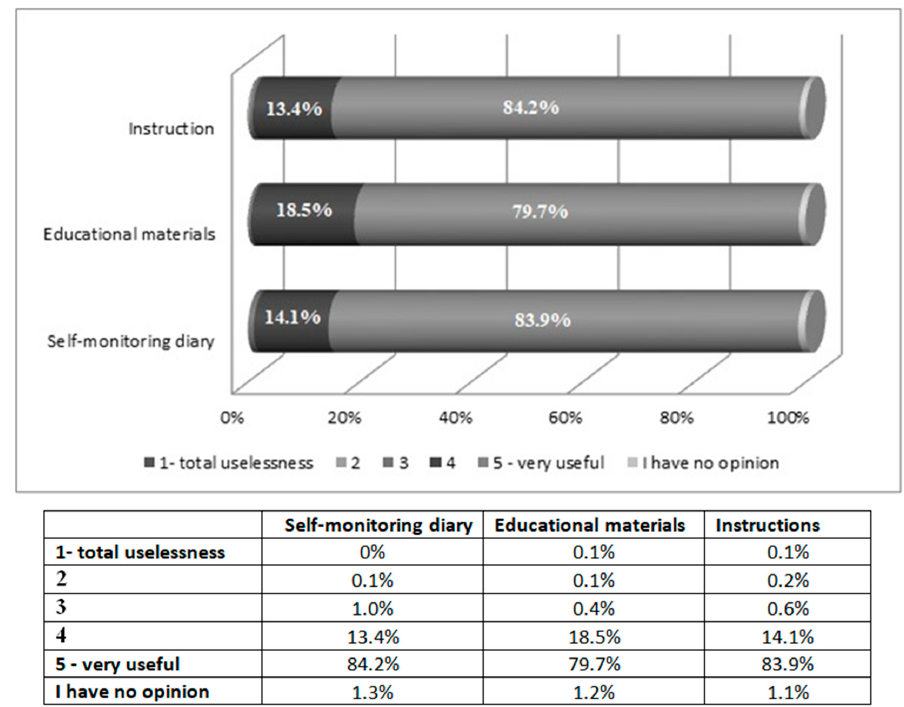
Figure 1. Assessment of education materials.